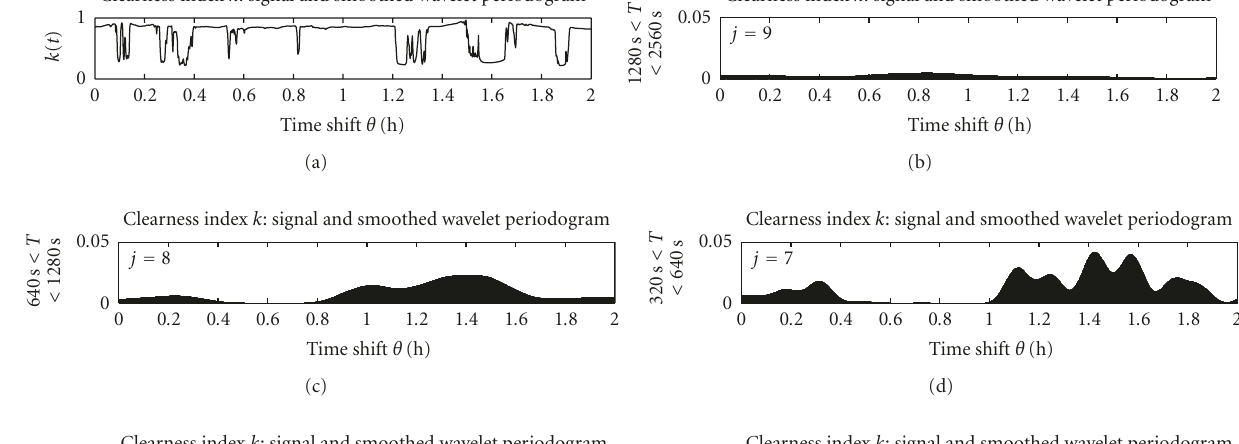
3Clearness index k : signal and smoothed wavelet periodogram j =